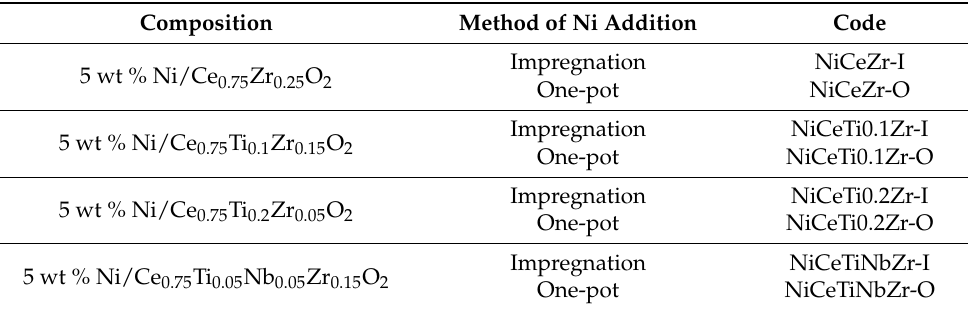
Table 1. The list of prepared